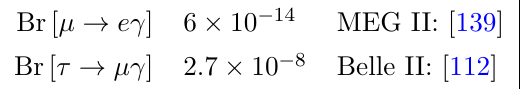
Table 7. Future sensitivities to Br( ‘ → ‘ 0 γ )